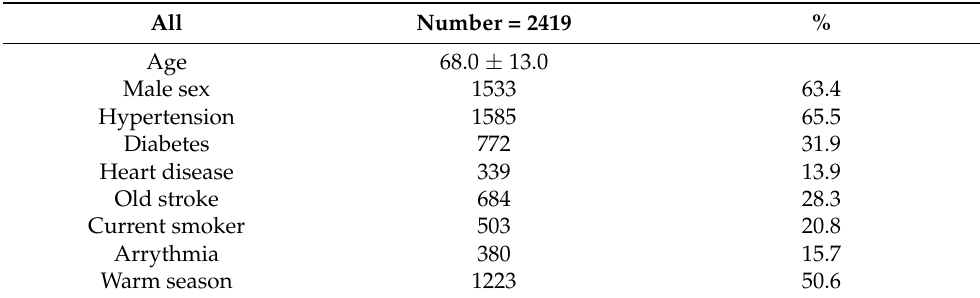
Table 1. Demographic characteristics of patients.